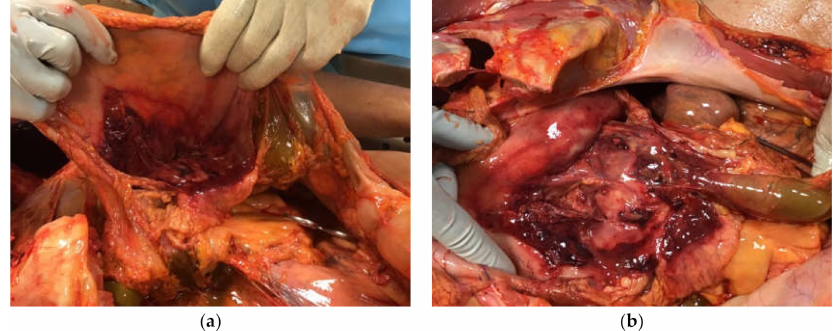
Figure 1. ( a , b ) Di ff use abdominal inflammation due to